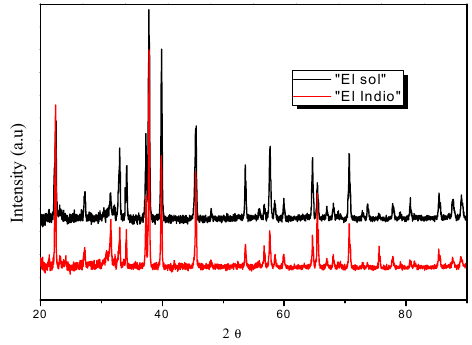
Figure 7. XRD patterns for commercial anilines.